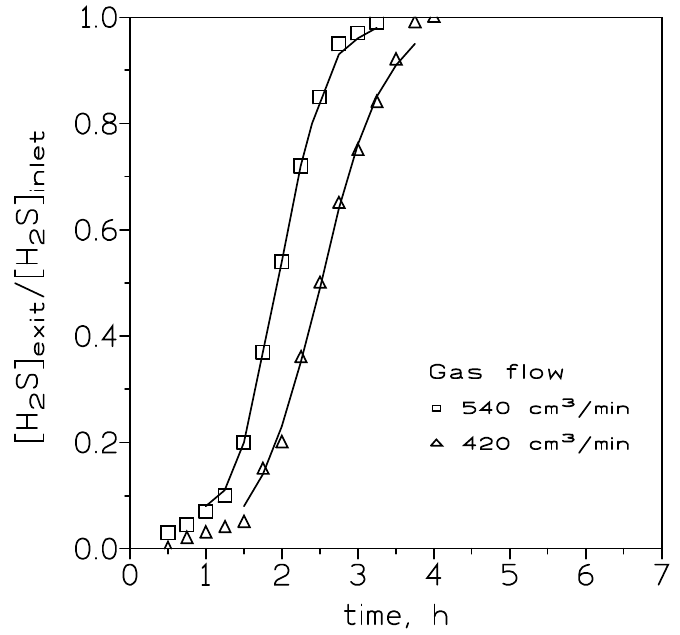
Figure 3. Experimental (points) and model (lines) breakthrough curves at various gas flows. H 2 S dosage: 400 mg. Adsorbent dosage: 4 g. Temperature: 20 °C.